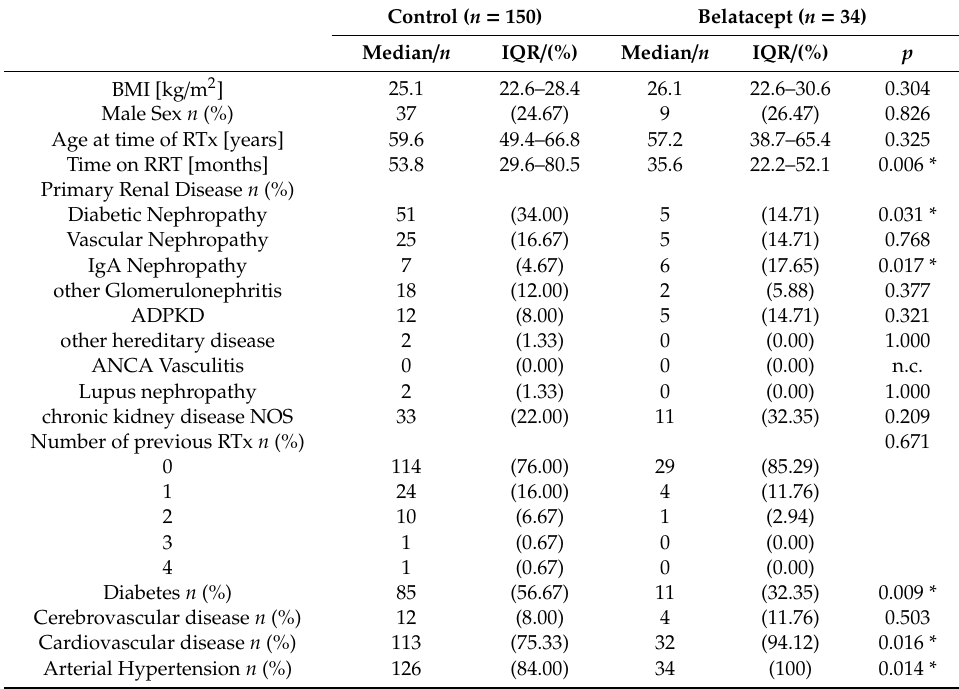
Table 1. Baseline data of control and Belatacept patients.